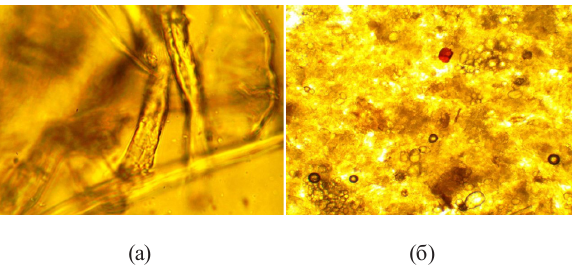
Figure 2 Histological structure of SuperCel dietary